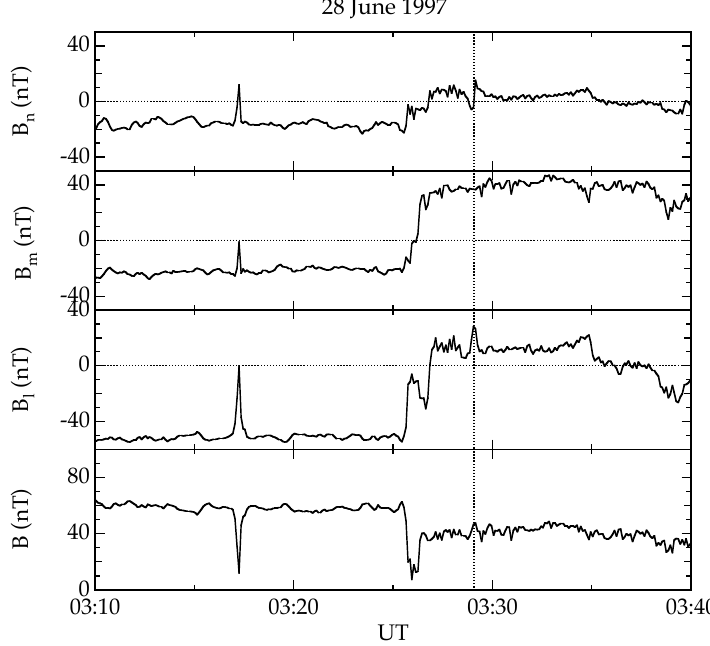
Fig. 2. Interball-1 magnetometer observations from 03:10 to 03:40 UT on 28 June 1997 in boundary normal coordinates (see text). Interball-1 crossed the magnetopause outbound at 03:26 UT. A vertical dashed line identifies a reverse (–,+) B n signature seen in the high-latitude magnetosheath just outside the northern lobe at 03:29